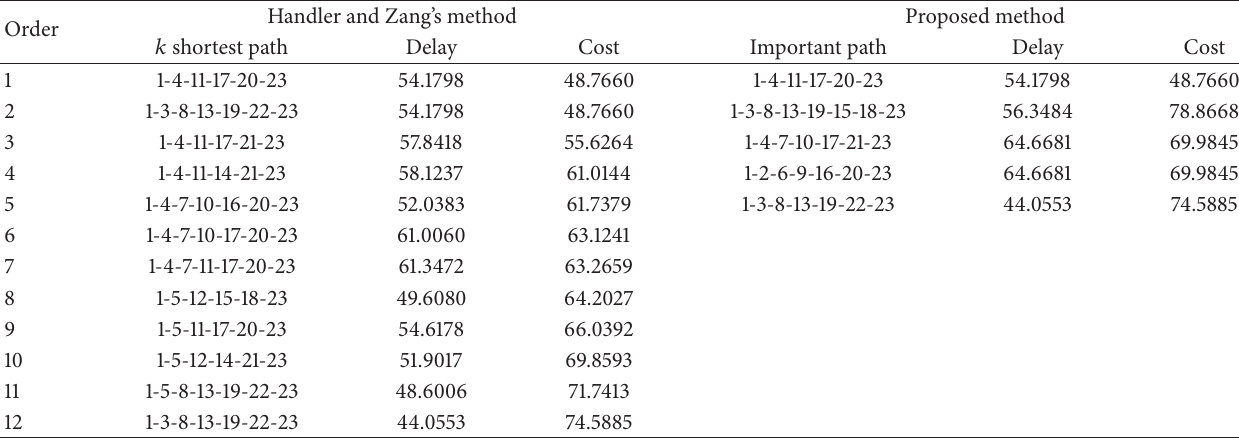
Table 3: Paths and their attributes.